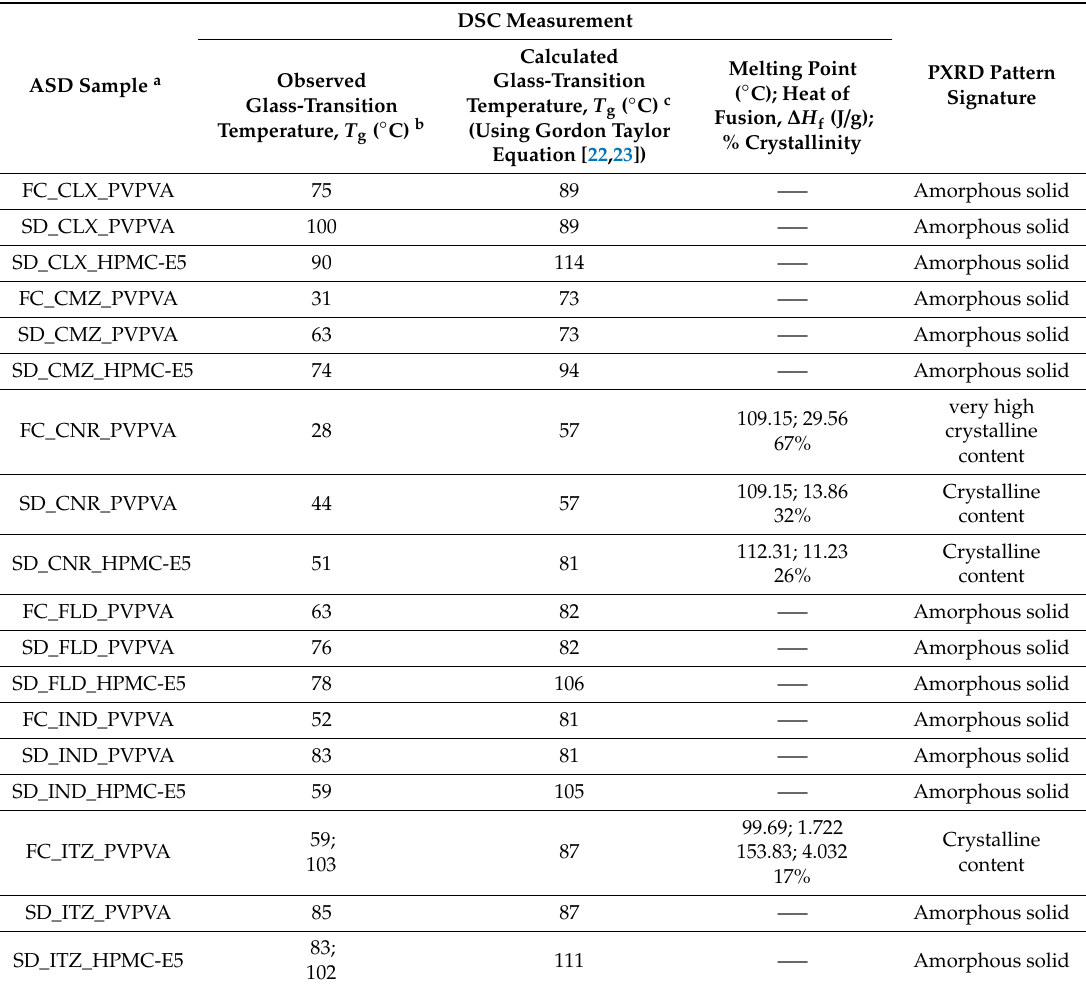
Table 2. Overview of experimental